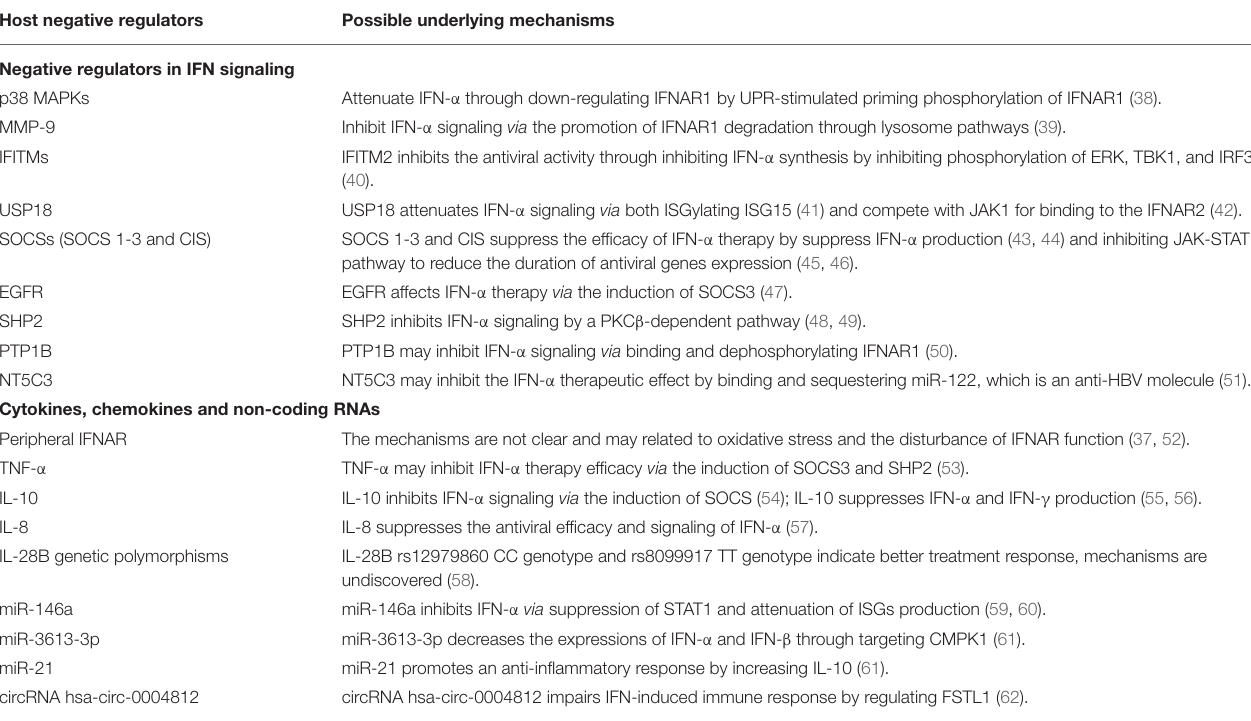
TABLE 1 | Involvement and the possible underlying mechanisms of host negative regulators in the inhibition of IFN- α therapy. Host negative